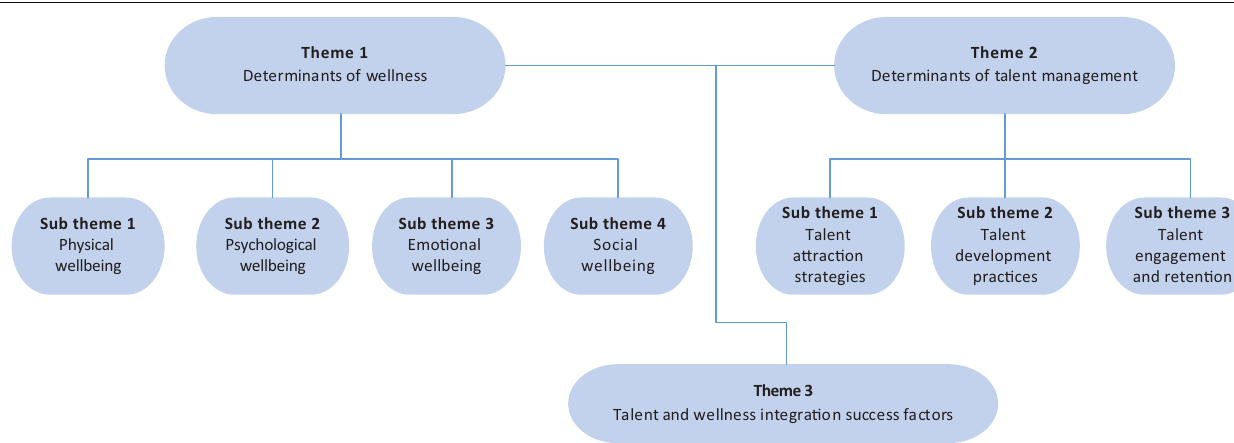
FIGURE 2: Themes and subthemes identified from data